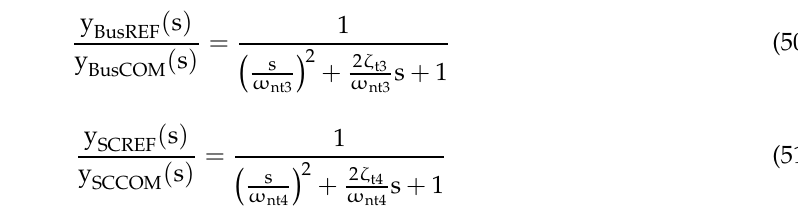
Figure 5. Proposed total energy stabilization.